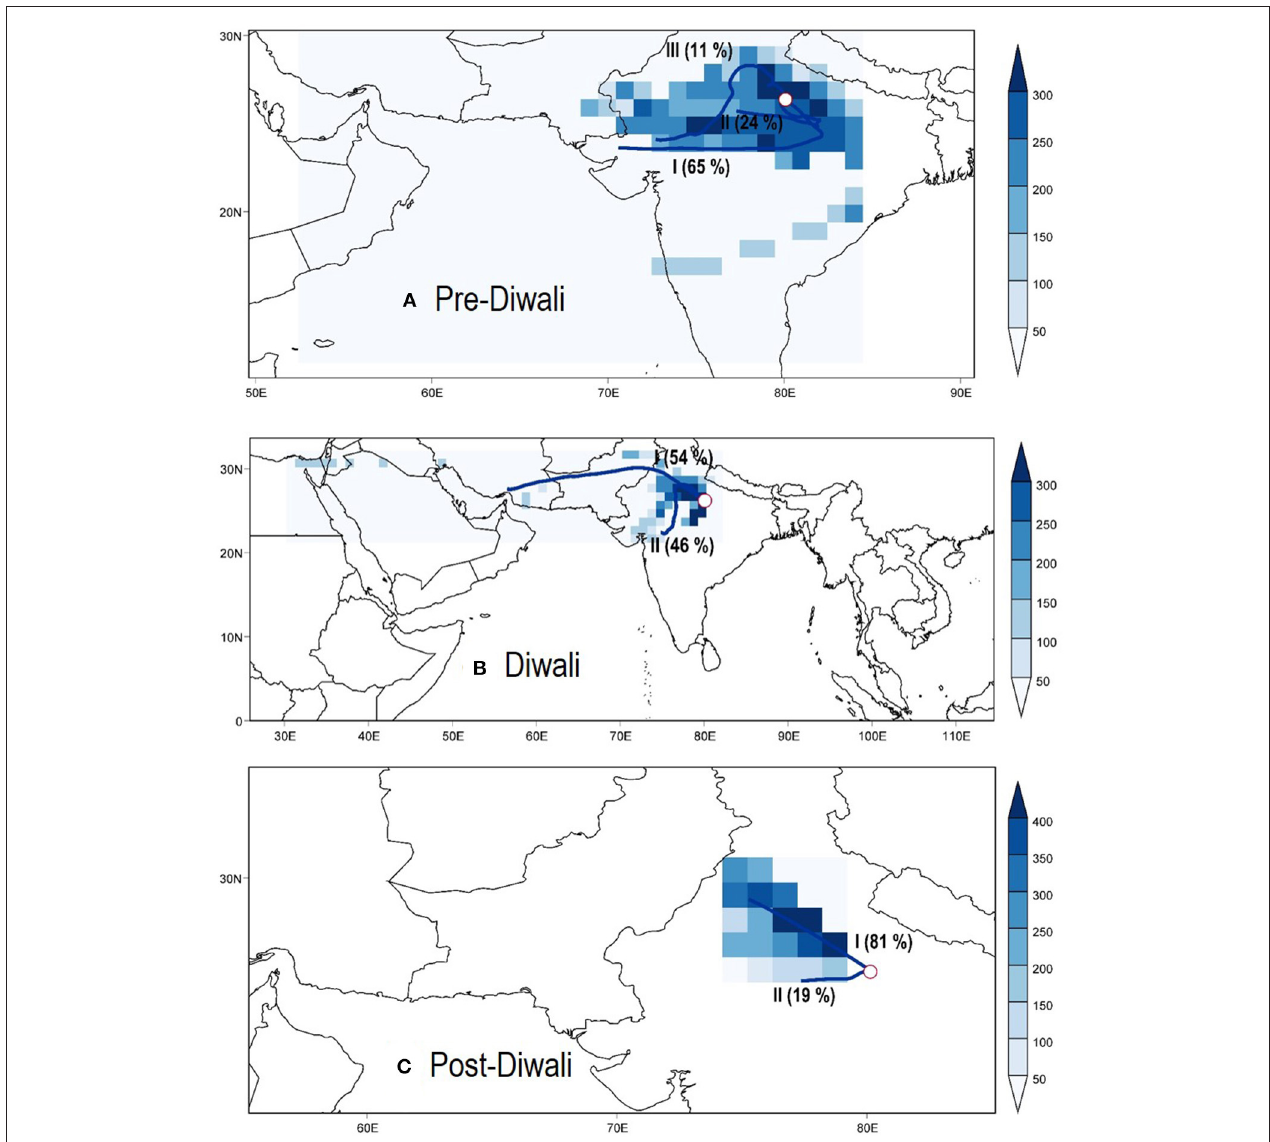
FIGURE 4 | CWT and cluster analysis of PM 2.5 during (A) Pre-Diwali, (B) Diwali, and (C) Post-Diwali study